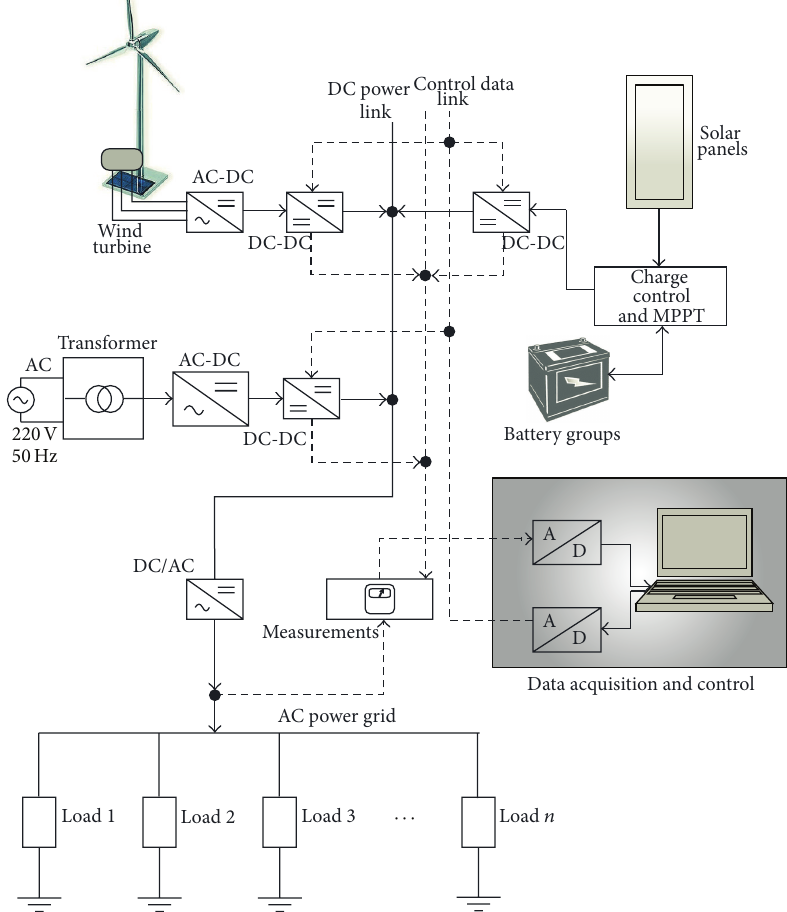
Figure 1: Renewable power generation system and energy